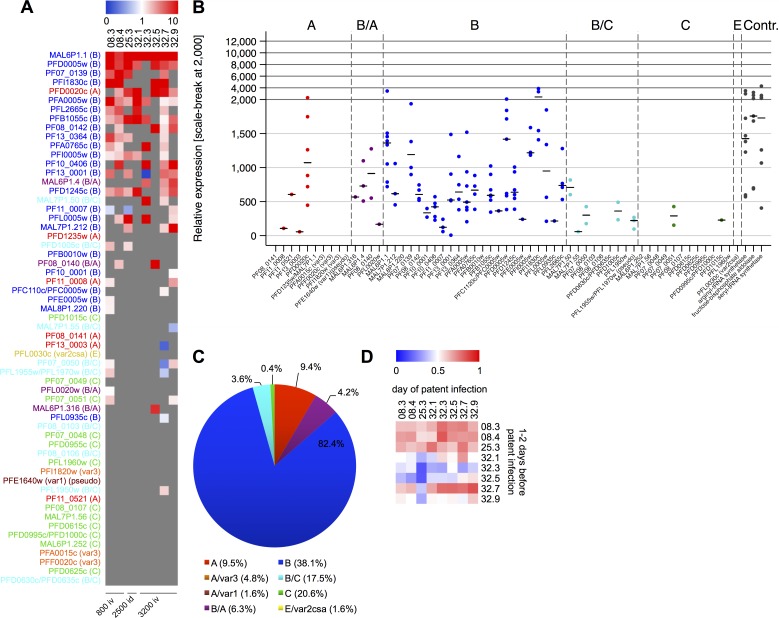

Var transcription profiles of parasites from infected volunteers 1–2 days before parasites were microscopically detectable.(A) Heat map showing the individual var gene expression profiles for samples obtained from volunteers one or two days before parasites were present in the thick blood smear. To correct for individual differences in the overall var expression levels, the expression for each var gene was normalized against the total var expression in each sample. Expression is ranked by mean expression obtained from “day of patent infection” samples (see Fig 1A). The color scale indicates the relative expression levels with red representing values above the median, blue representing values below the median, and white representing median. Grey means not detected. (B) Relative gene expression is shown in a dot plot for the volunteer samples one time point before thick blood smear positivity (n = 8). Gene IDs of var genes and controls are indicated on the x-axis, var gene groups are indicated above the graph. (C) The distribution of var transcripts according to var group affiliation in the volunteer samples 1–2 days before parasites were detected in the thick blood smear is displayed by summarization of the total var gene expression and calculation of the proportion for each var group. The genomic proportion of each var gene group is indicated after the color code. (D) The pairwise Spearman’s rank correlation heat map demonstrates a positive correlation between the expression profiles on the day of first microscopically detectable parasitemia and 1–2 days before in the same volunteer and between volunteer samples.